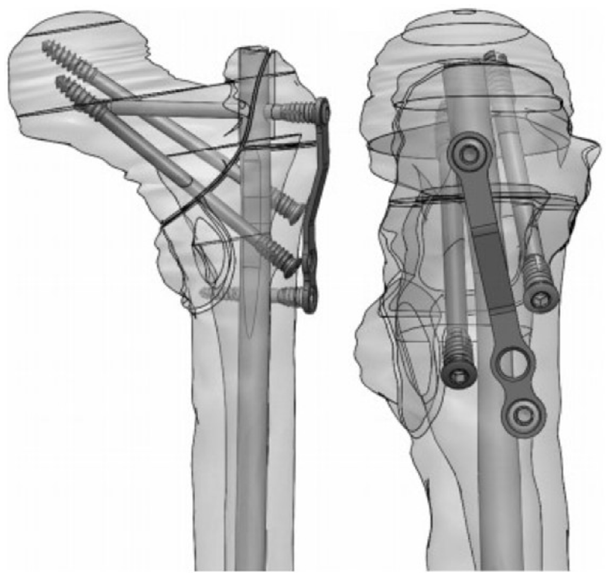
Figure 1. SIGN hip construct (SHC)